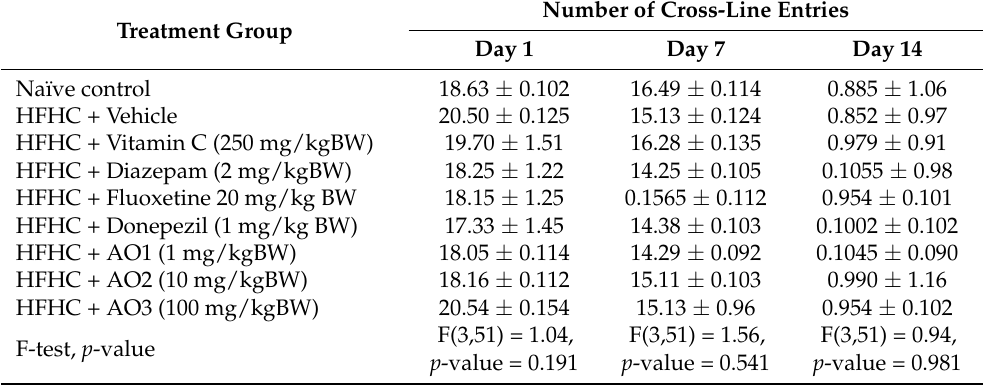
Table 1. Effect of the functional ingredient containing cashew leaf extract and cashew apple pomace- derived dietary fiber (AO) on number of cross-line entries. Data are presented as mean ± SEM) n = 6/group.